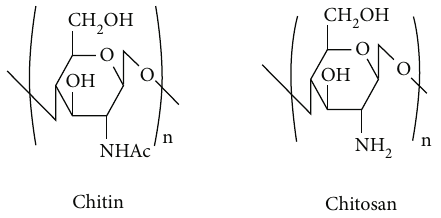
Figure 1: Structure of monomer of chitin and